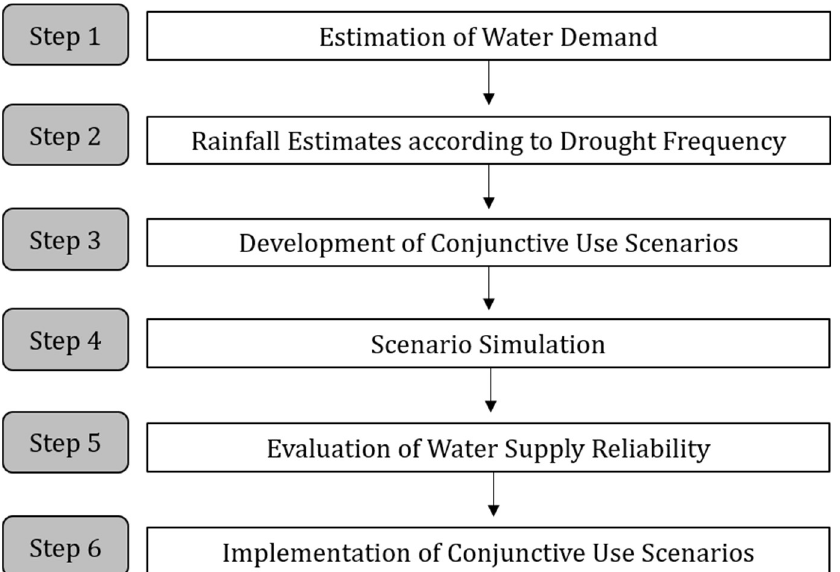
Figure 6. Procedure for conjunctive use of multiple water sources.